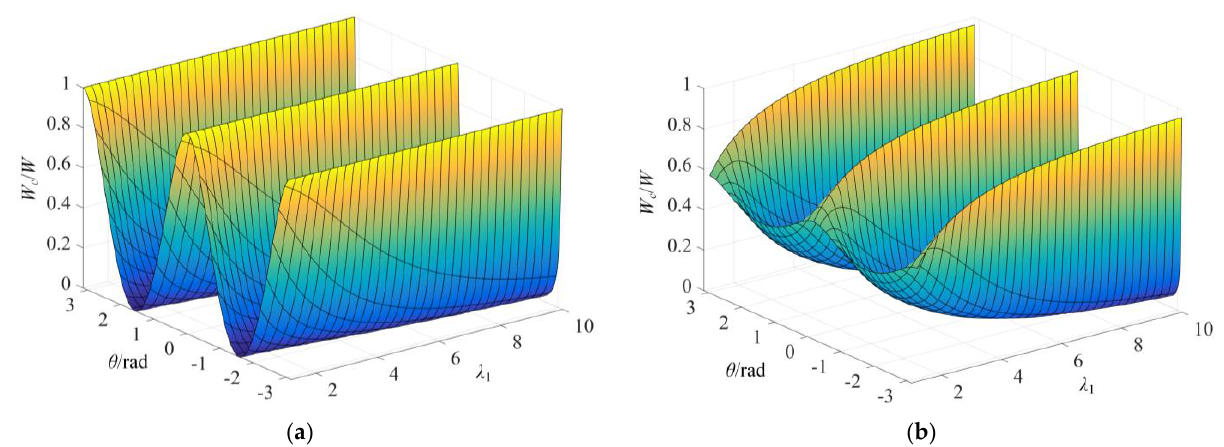
Figure 6. Distribution of the ratio of CED to SED under typical strain state: ( a ) Uniaxial tension ( b = λ 1 −3/2 ); ( b ) simple shear ( b = λ 1 −2 ). ( b = λ 1 − 3/2 ); ( b ) simple shear ( b = λ 1 − 2